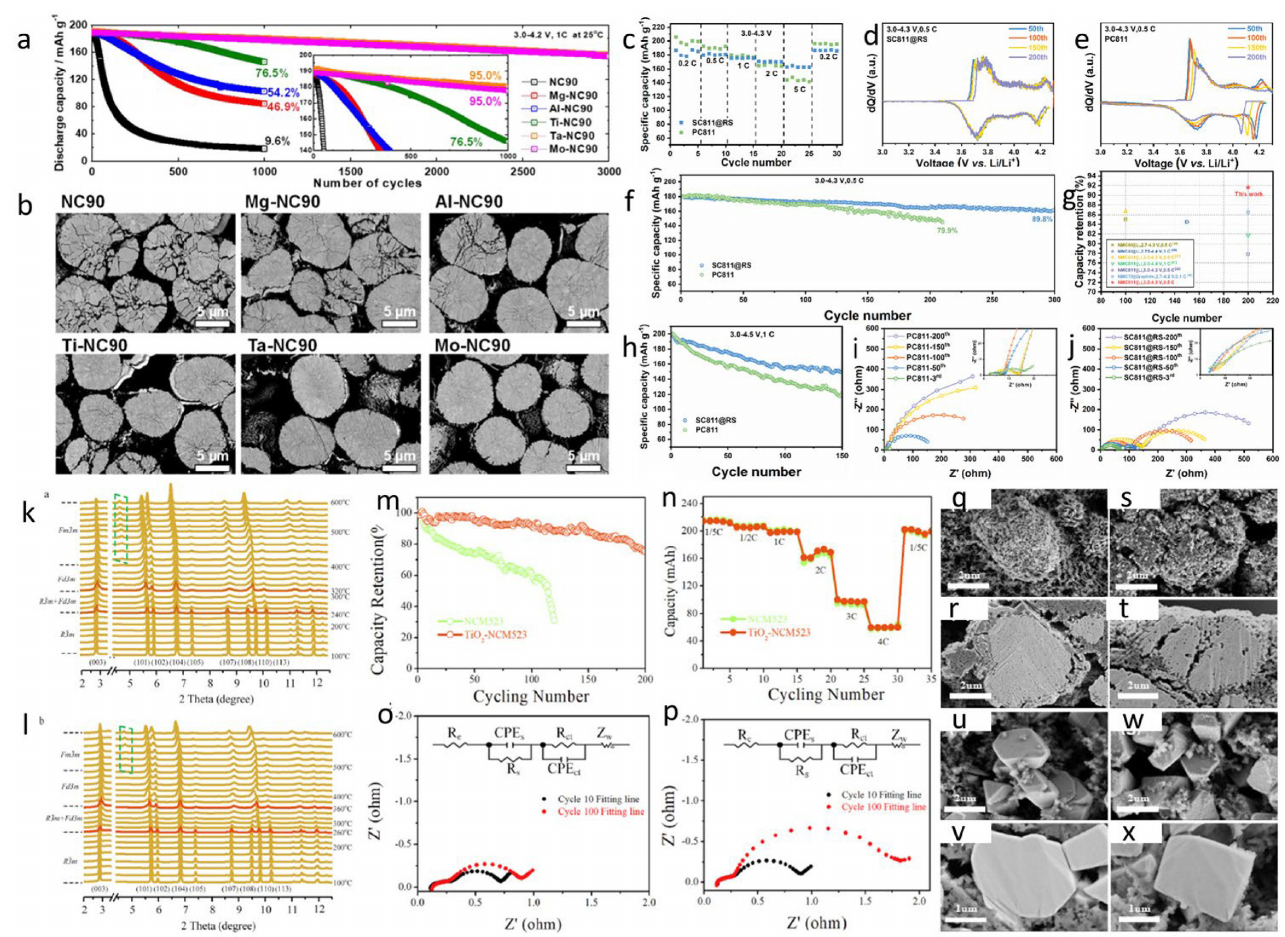
Figure 7. ( a ) Cycling of NC90, Mg-NC90, Al-NC90, Ti-NC90, Ta-NC90, and Mo-NC90 cathodes in pouch-type full cells within the voltage range of 3.0–4.2 V versus graphite at 1C (200mA g − 1 )